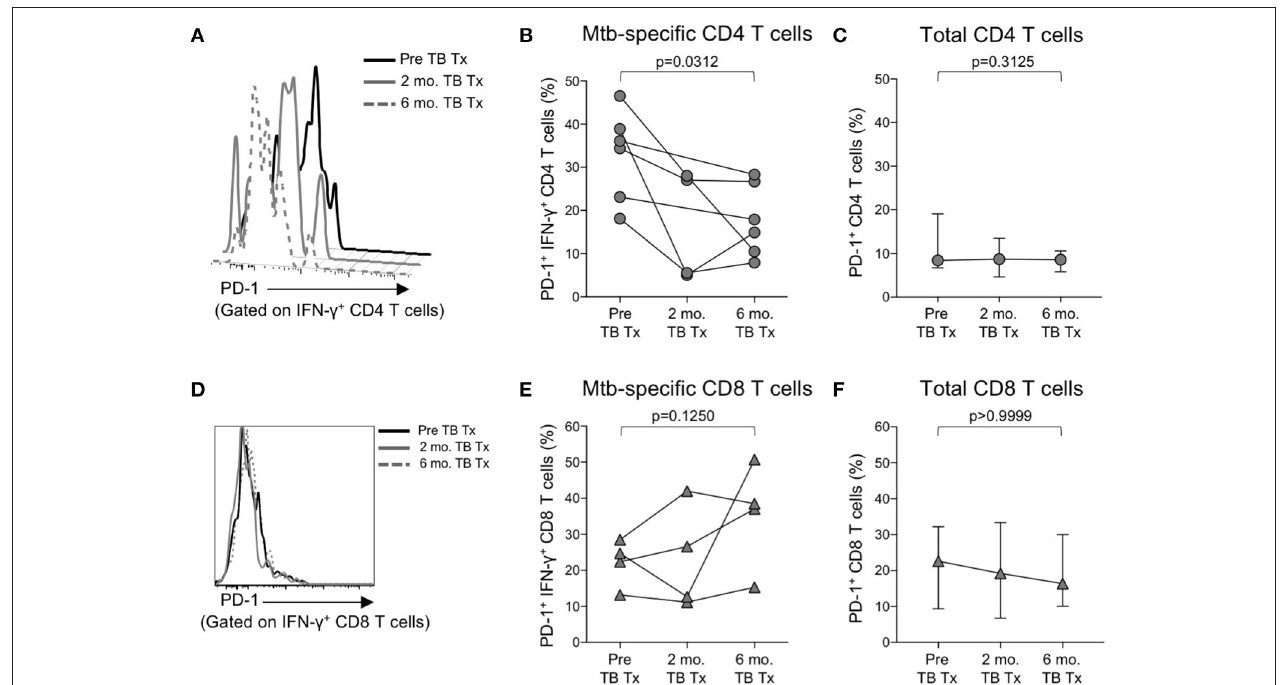
FIGURE 5 | PD-1 expression on Mtb-specific CD4T cells is associated with bacterial load. Flow cytometry was used to measure PD-1 expression on CFP-10/ESAT-6-specific IFN- γ + CD4 and CD8T cells in smear + TB patients at 3 time points: prior to initiation of TB treatment (pre-TB Tx), and 2 and 6 months following initiation of treatment. (A) Histogram overlay of PD-1 expression on IFN- γ + CD4T cells following 8h stimulation of whole blood from a smear + TB patient with a CFP-10 peptide pool at the three time points indicated. PD-1 MFI is shown after gating on viable CD3 + CD4 + IFN- γ + lymphocytes. (B) Longitudinal analysis of PD-1 expression on CFP-10/ESAT-6-specific IFN- γ + CD4T cells within the same individuals over time ( n = 6 smear + TB patients with IFN- γ + CD4T cell responses detectable at more than one time point). (C) Median and interquartile range of PD-1 expression on total CD4T cells from the same smear + TB patients shown in (B)